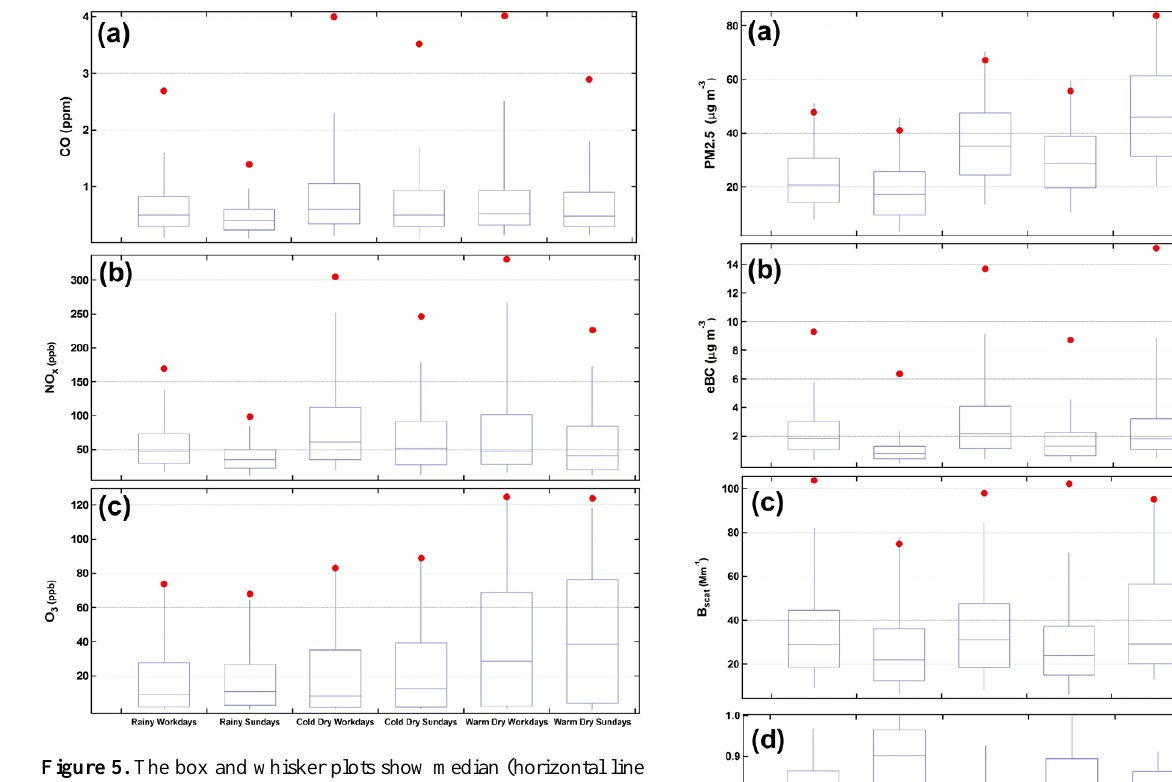
Figure 5. The box and whisker plots show median (horizontal line within the box), 25% quantile (bottom of box), 75% quantile (top of box), 5% quantile (bottom whisker) and 95% quantile (top whisker). In addition the average of the daily maxima are shown with the red filled circles. The trends in these statistics as a function of season, workdays and Sundays are plotted for (a) CO, (b) NO x and (c) O 3 .